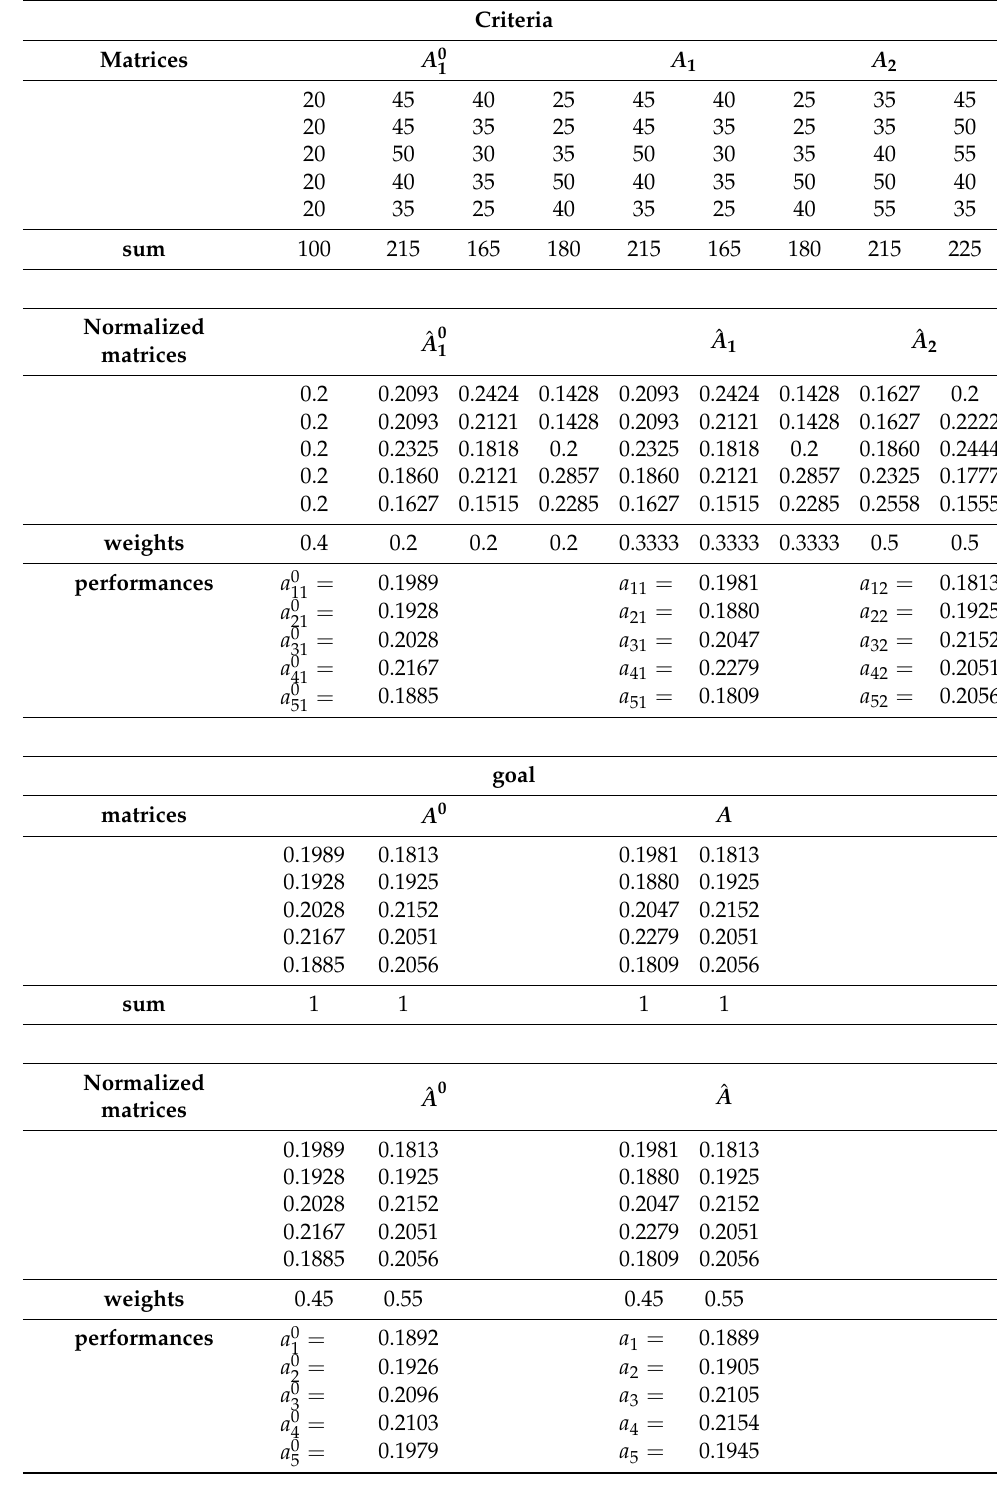
Table A2. Summary of Example 1 solution under L 2